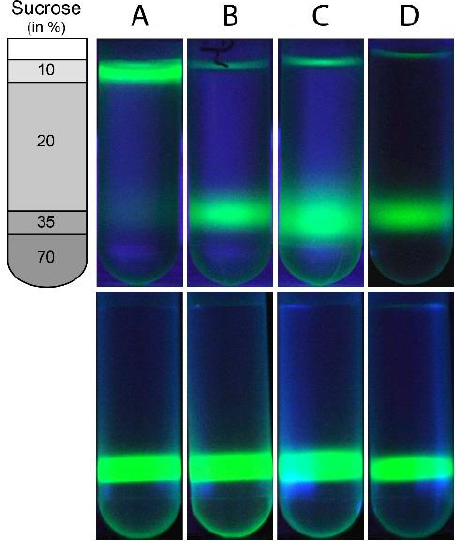
Figure 1. Liposome floatation assay of wild type and mutant NS4A(1 – 48). Alexa-488-labeled NS4A(1 – 48) ( A ); Alexa-488-labeled NS4A(1 – 48, L6E;M10E) ( B ); or free Alexa Fluor 488 dye ( C ) were mixed with sonicated POPC liposomes and loaded with the 35% ( w / v ) sucrose layer of a sucrose step gradient schematically shown on the left; Alexa-488-labeled NS4A(1 – 48) without liposomes was loaded with the 35% ( w / v ) sucrose layer in lane ( D ). Note: The narrow green line at the top of tubes ( B ), ( C ) and ( D ) results from reflection of fluorescence light at the air buffer interface rather than the presence of dye. Fluorescence